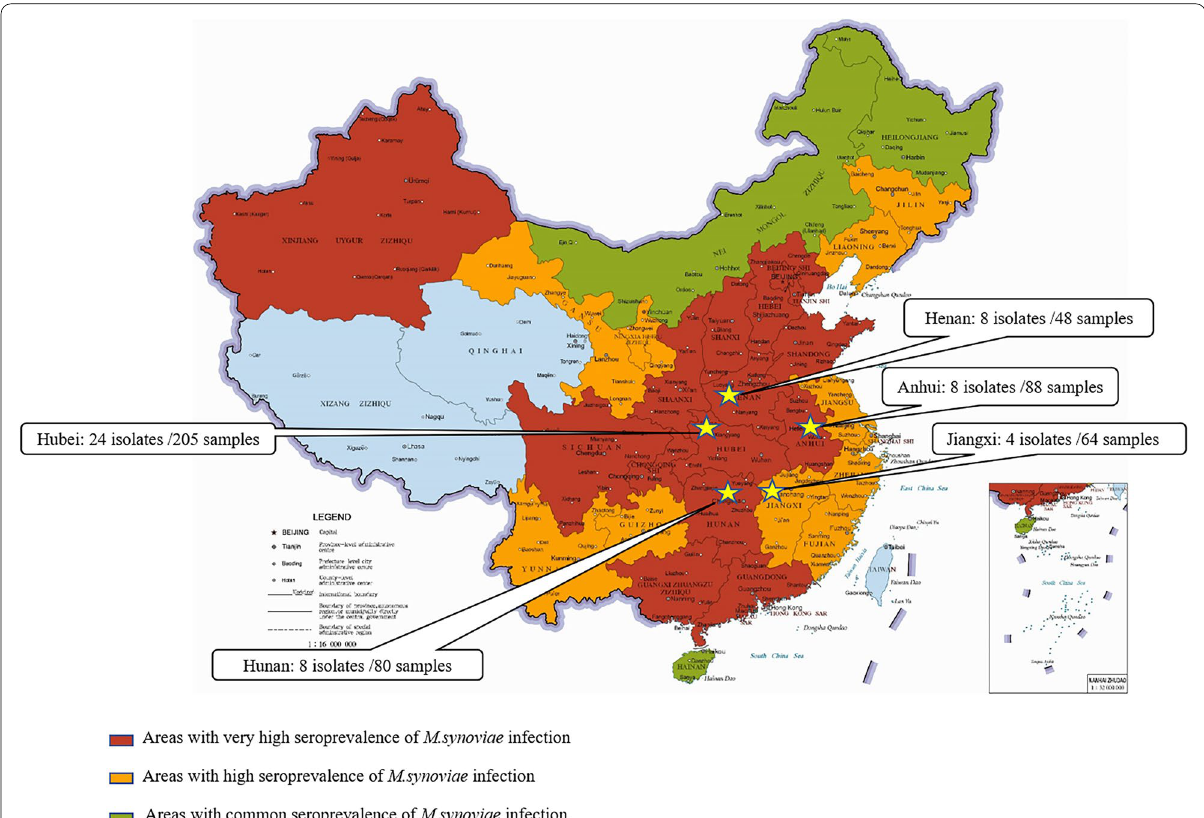
Fig. 2 Regional distribution of M. synoviae isolates and seroprevalence of M. synoviae infection in different provinces of China. The number of samples collected in each province and the isolates are shown in boxes. Censor code of this map: GS (2019) 1695